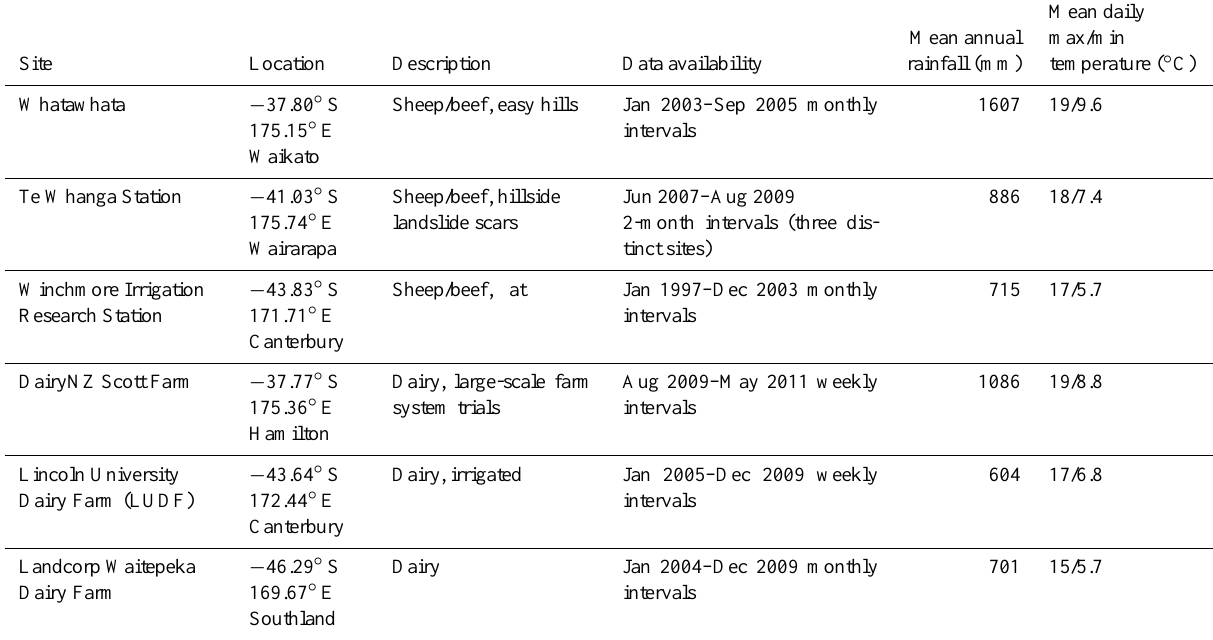
Table 1. Calibration sites, location, description and dates of pasture growth data used for model